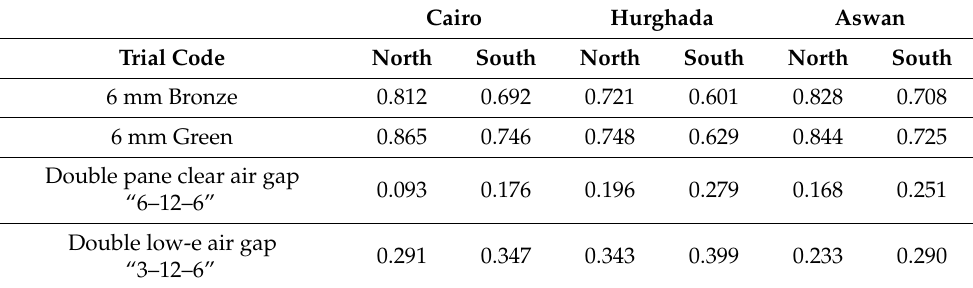
Table 7. The scores for all transparent alternatives in the overall normalized scenario.